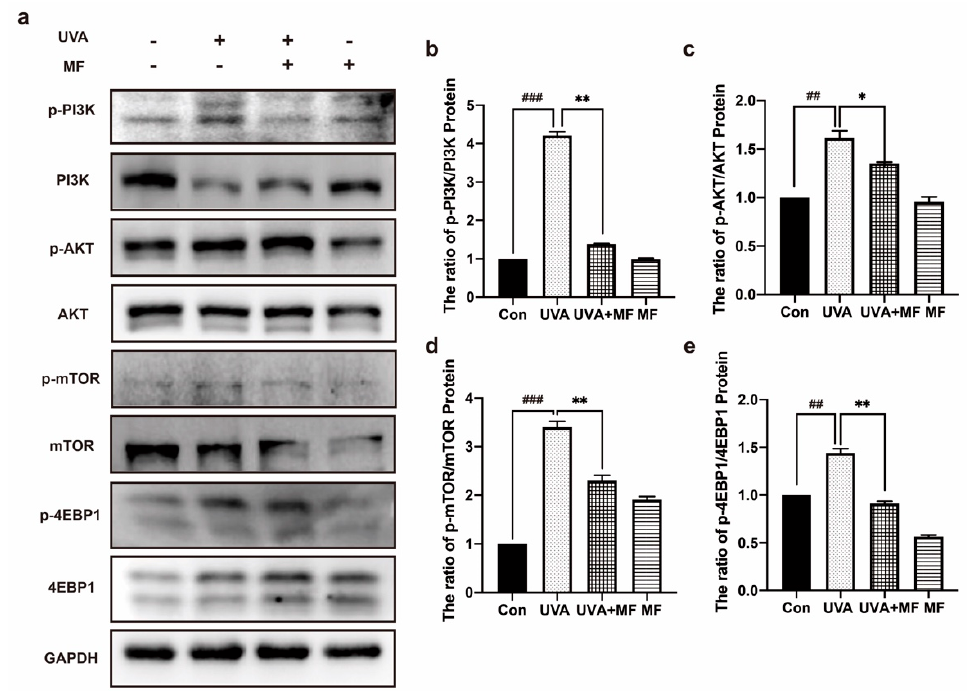
Figure 3. The PI3K/AKT/mTOR signaling pathway was decreased by metformin in UVA-induced senescent cells. ( a − e ) Cells were treated with UVA alone or in combination with 100 µ M metformin, the protein levels of p-PI3K/PI3K, p-AKT/AKT, p-mTOR/mTOR, p-4EBP1/4EBP1, were measured by western blot. Data are presented as mean ± SD, n = 3. ## p < 0.01, ### p < 0.001 vs. control cells, * p < 0.05, ** p <0.01 vs. UVA ‐ treated cells.